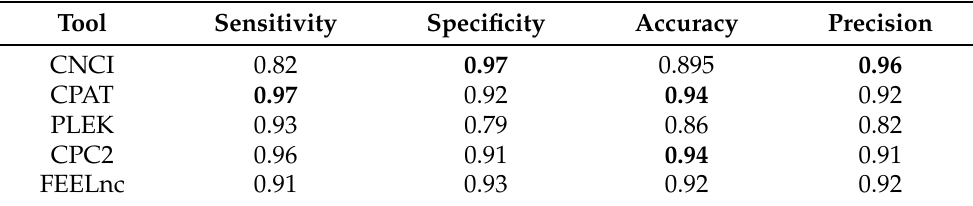
Table 3. Classification performance measures of benchmarked tools. We calculated sensitivity, specificity, precision and raw accuracy based on classification of 400 randomly chosen human transcripts, 200 of which were protein-coding and 200 were confirmed non-coding RNAs of 200 nt to 3500 nt length. The transcripts used in this benchmark were extracted from the RefSeq database [40] (ver. 38). Bold faced values highlight the maximum achieved for each